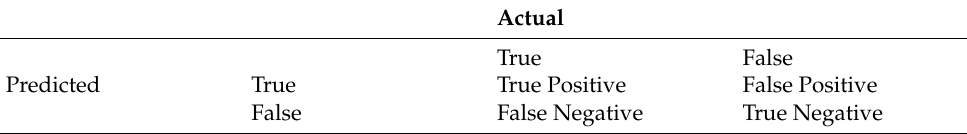
Table 1. A 2 × 2 confusion